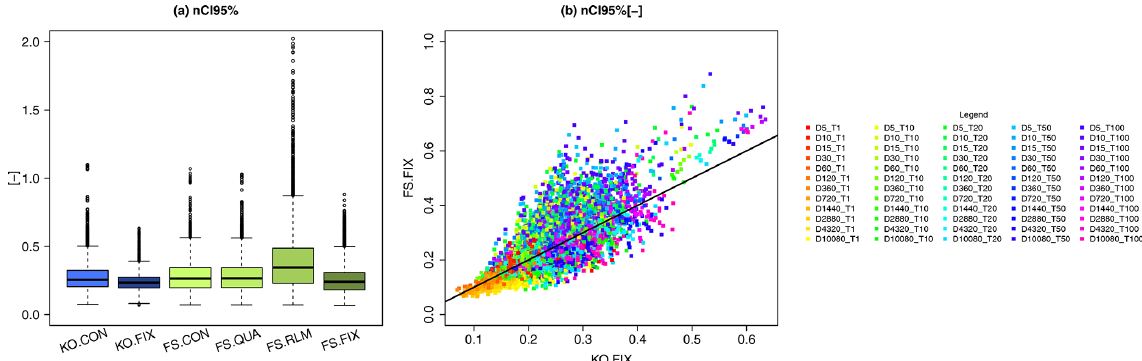
Figure 11. On the left is the comparison of the normalised 95% confidence interval width [–] for the methods and shape parameters selected for the generalisation of the DDF values over all the durations (see Table 5 for a summary of the methods). On the right is a direct comparison of the normalised 95% confidence interval width [–] for KO.FIX ( x axis) with FS.FIX ( y axis) for each duration D and return period T[a] (shown in different